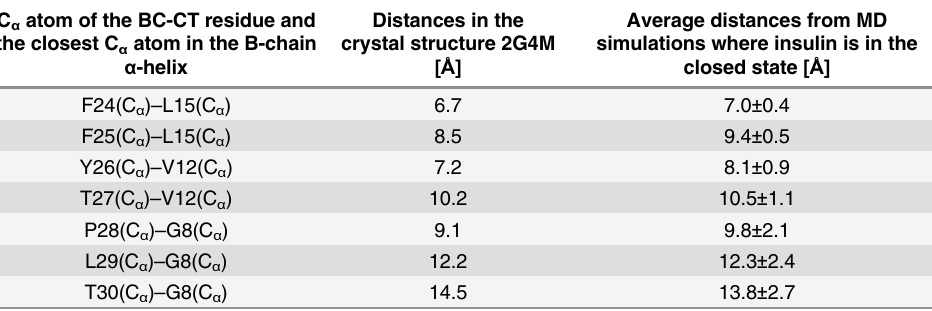
Table 1. The BC-CT and B-chain α -helix residues used to characterize the dynamics of the BC-CT. C α atom of the BC-CT residue and the closest C α atom in the